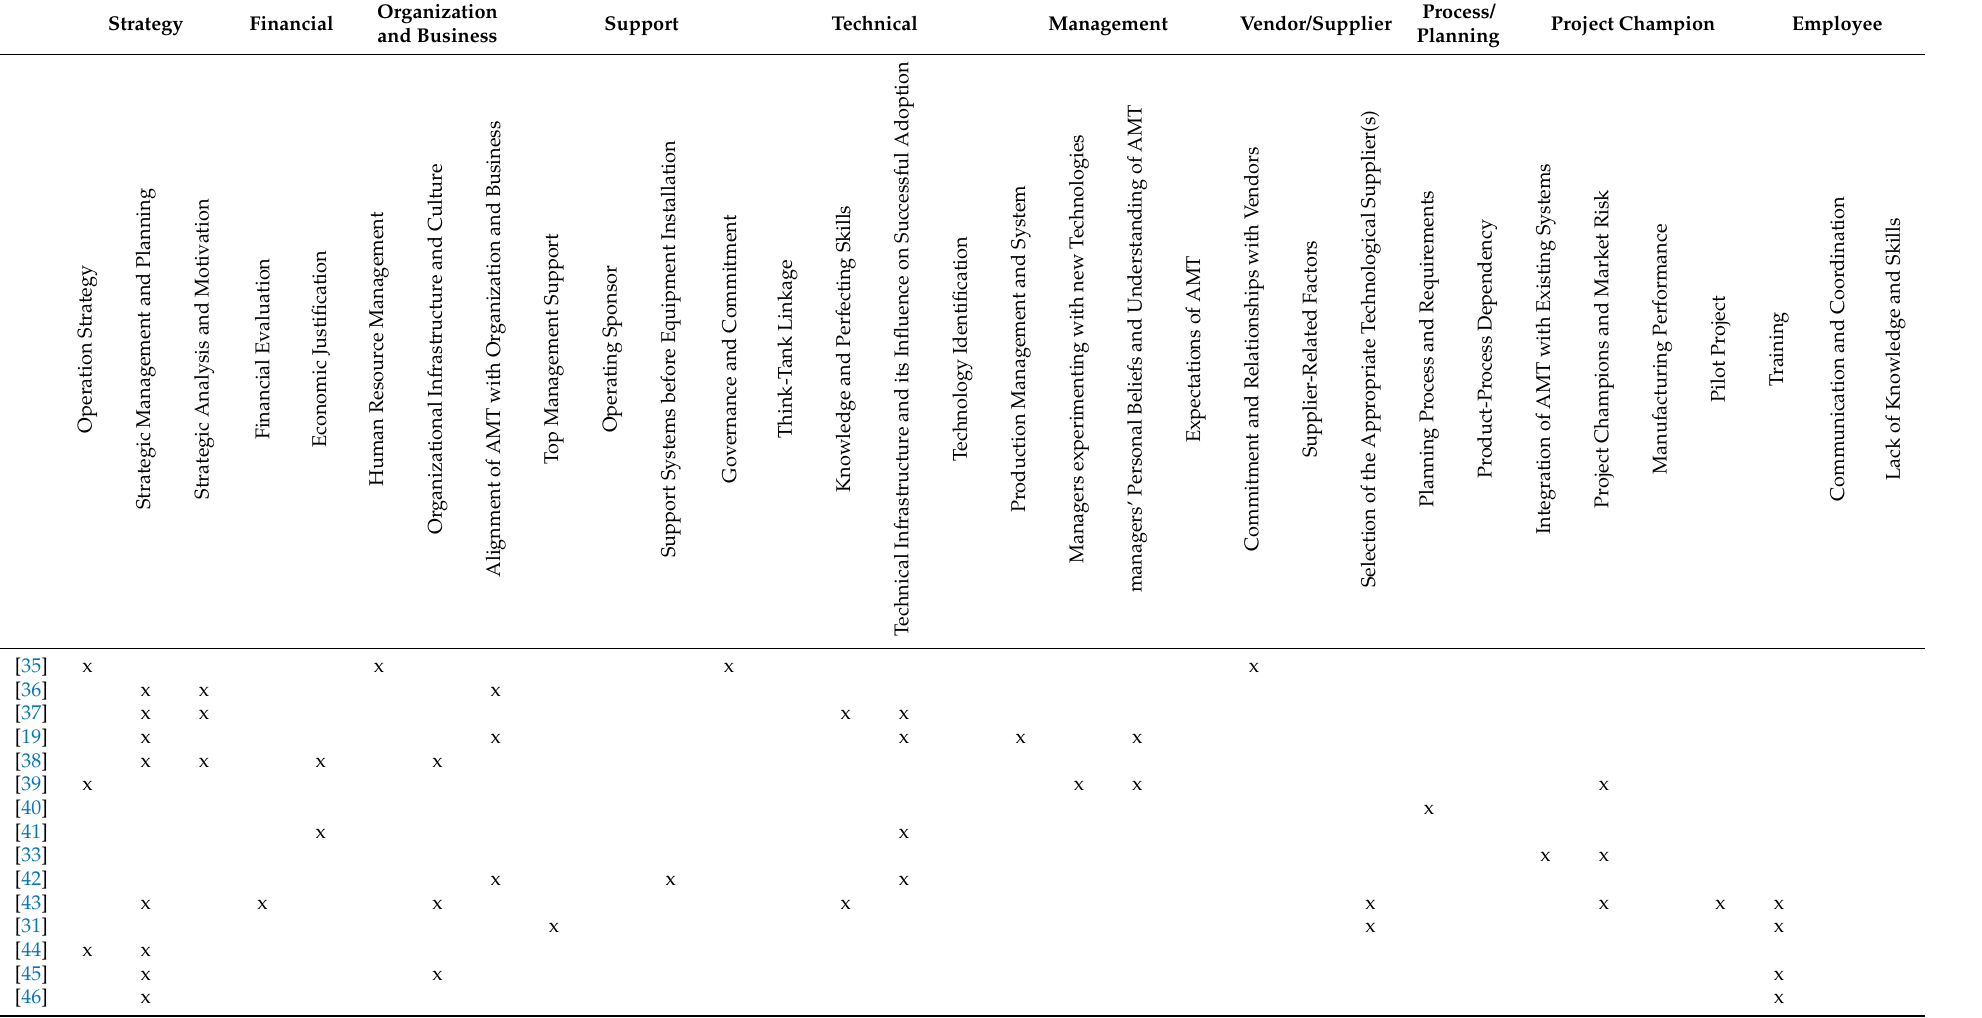
Table 1. Identification of the critical factors which influence the successful implementation of